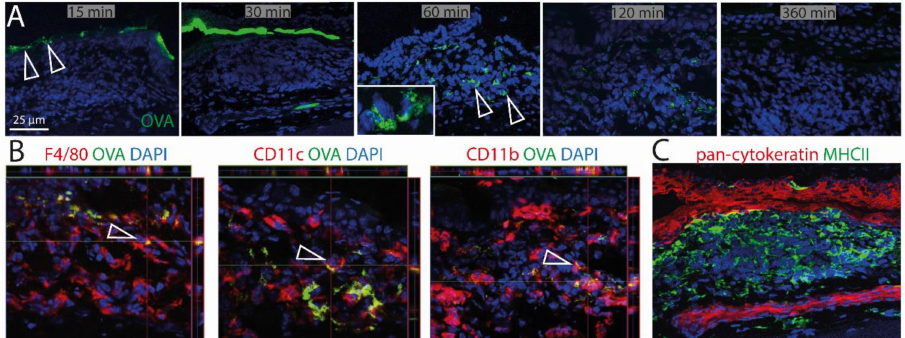
Figure 5. Uptake of soluble antigen in CALT. ( A ) Upper row. Topically applied, fluorescent OVA was transported via the lymphoepithelium into KLH / CtB induced CALT. OVA was detectable 60–120 min after application within CALT (see inlay). Three hundred and sixty minutes after the application, OVA was no longer detectable. Arrows show OVA accumulated above and within CALT. ( B ) Image stacks proved a co-localization of F4 / 80 + , CD11b + , CD11c + cells in CALT with OVA. Arrows indicate OVA uptake by APCs in CALT. ( C ) Epithelial cells above CALT do not express MHCII (green). (green: OVA; red: CD11b, CD11c, F4 / 80, pan-cytokeratin; blue-nuclei; bar = 25 µ